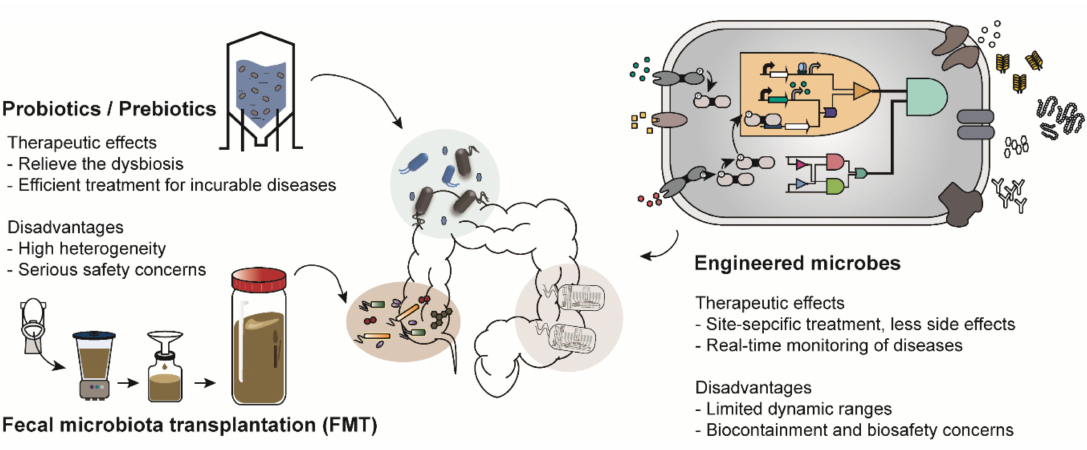
Figure 1. Examples of microbiome-based therapies. Probiotics / prebiotics, administration of microbes that have beneficial e ff ects on human health; Fecal microbiota transplantation (FMT), transfer of the processed feces of healthy people; Engineered microbes, transformation of the genetic platforms to sense and treat the diseases using genetic